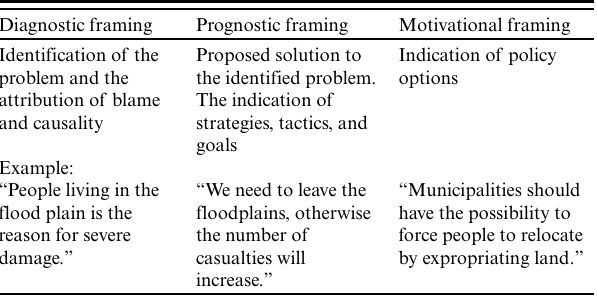
Table 2 . Description of the core framing tasks (cf. Lindekilde